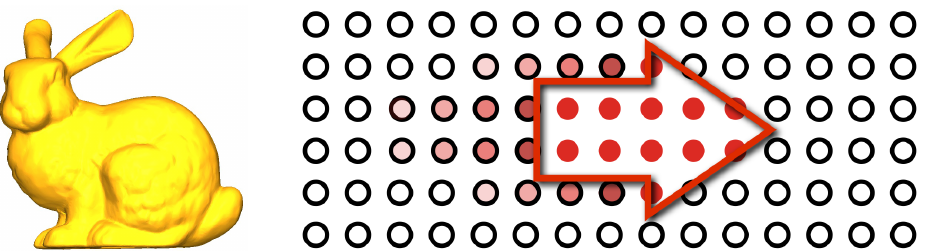
Figure 2. Grid generation in the context of the lattice Boltzmann method (LBM): mapping of discrete triangle mesh representations of geometries ( left ) to the Cartesian grid ( right , red